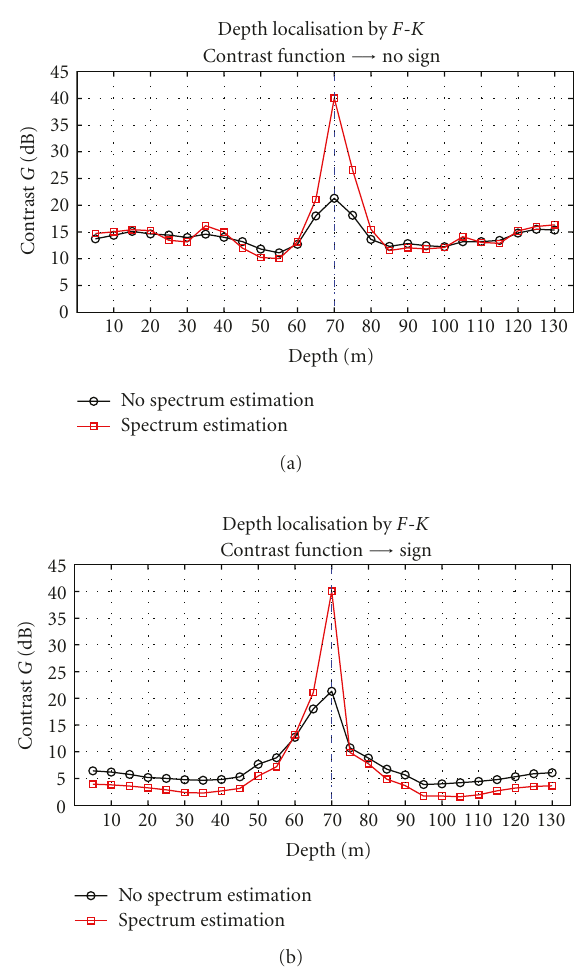
Figure 22: Contrast functions G for depth source localization by F - K approach combined with source spectrum estimation. The simulation is given for source ULF-2 located at 70m of depth and 10km distant from the HLA. (a) shows the gain given by taking into account the estimated spectrum of an unknown source for localization method without mode signs. (b) shows this gain in case of localization algorithm with integrated mode signs into the contrast